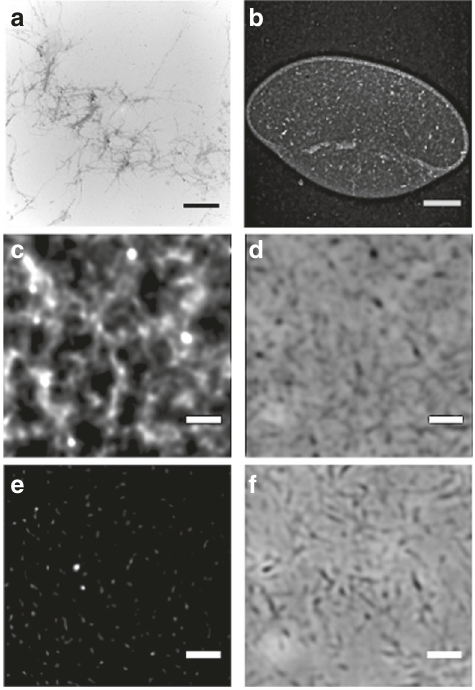
Fig. 7 NP 1 -P 188 staining of insulin fi brils ( fl uorescence shown in white for clarity). a TEM images of insulin fi brils (scale bar = 2 µ m). b Fluorescence imaging of insulin fi brils in water droplet after treatment with NP 1 -P 188 (scale bar 20 µ m). c Fluorescence and d differential interference contrast (DIC) images of fi brils after treatment with NP 1 -P 188 (scale bar 5 µ m). e Fluorescence and f DIC images of fi brils after treatment with P 188 (scale bar 5 µ m). See Supplementary Fig. 12 for overlay of fl uorescence and DIC